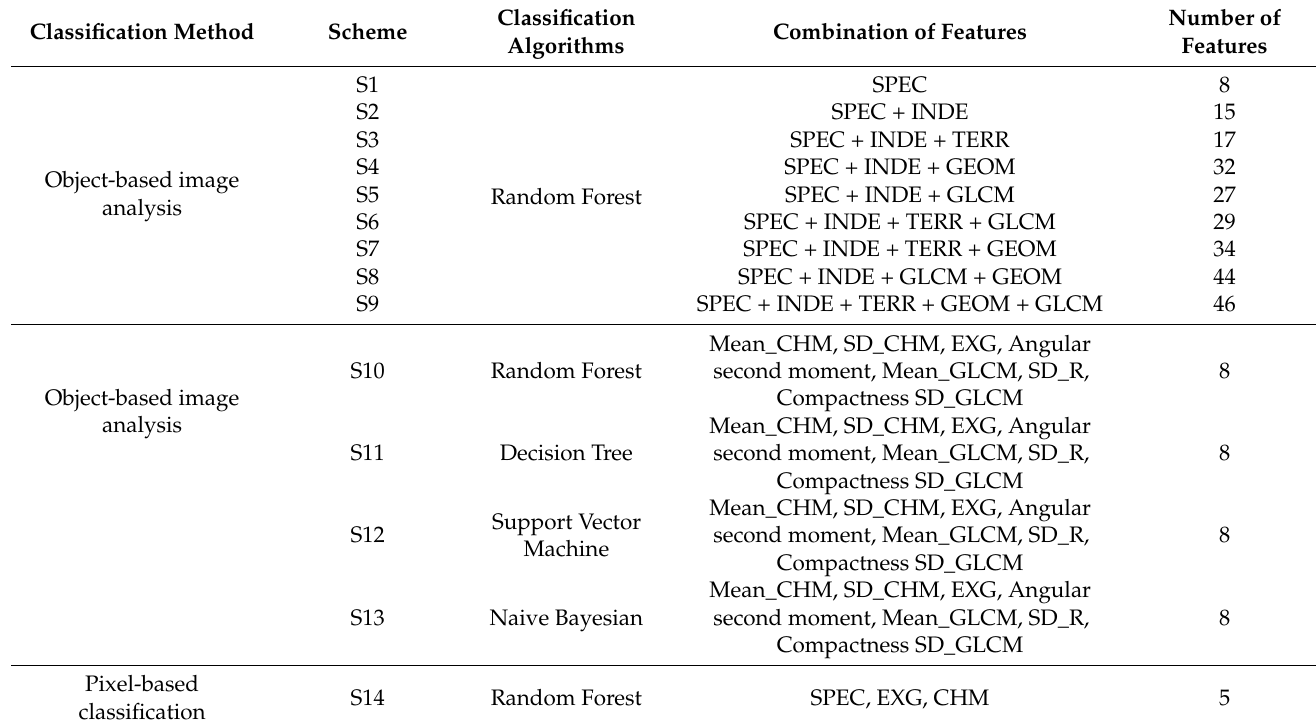
Table 4. Design of experimental